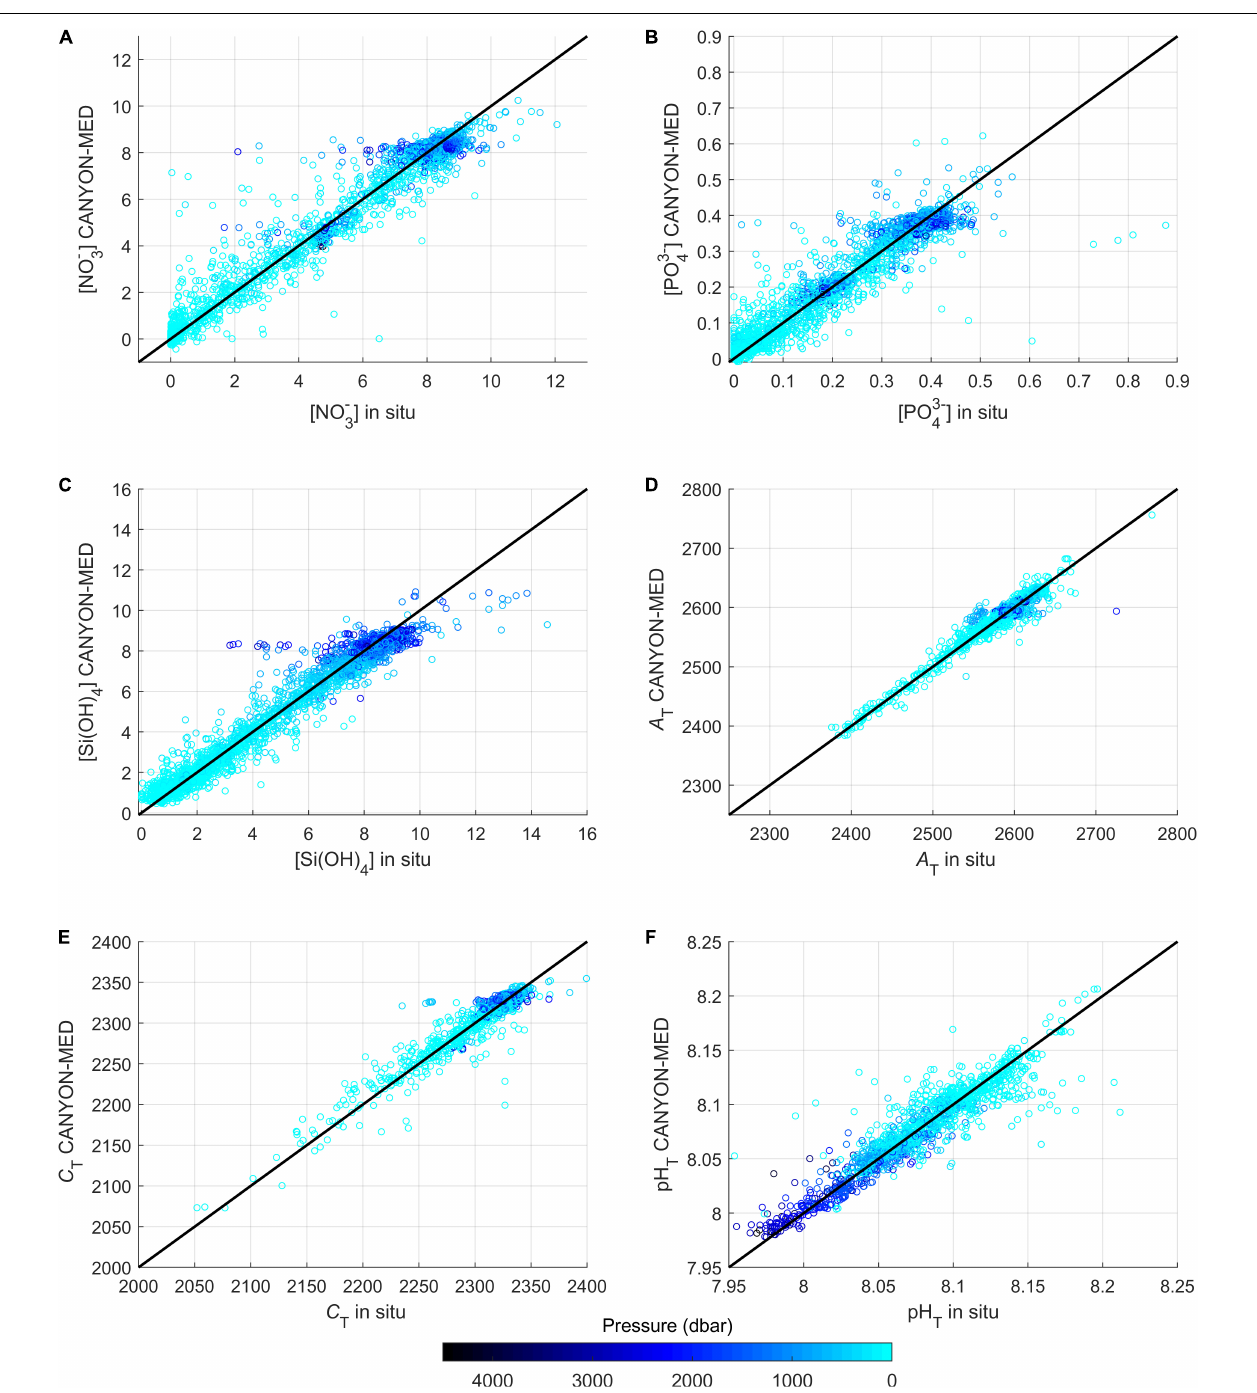
FIGURE 4 | Comparison of the CANYON-MED-retrieved values with the corresponding in situ measurements according to pressure for (A) NO − 3 , (B) PO 3 − 4 , (C) Si(OH) 4 , (D) A T , (E) C T , and (F) pH T . The darker blue points correspond to the deeper points whereas the lighter ones correspond to values closer to the surface. The 1:1 line is shown in black. The corresponding statistics are shown in Table 2 .